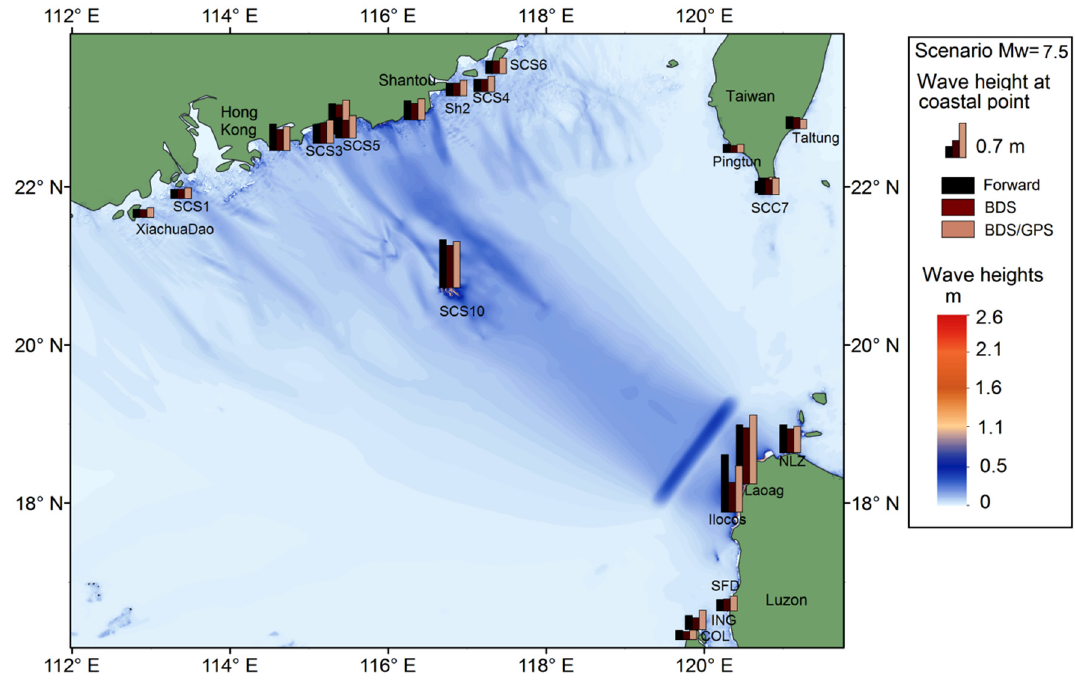
Figure 7. Simulated tsunami scenarios. The color map shows the maximum wave height in the forward model (Figure 6a) after 6 h of tsunami propagation. Vertical bars are maximum wave heights as recorded at selected coastal locations for the three propagation models: the forward model (black); the model with the source as inverted from BDS-displacements (dark grey, Figure 6b); and the model with the source as inverted from joint BDS/GPS-displacements (light grey, Figure 6c).